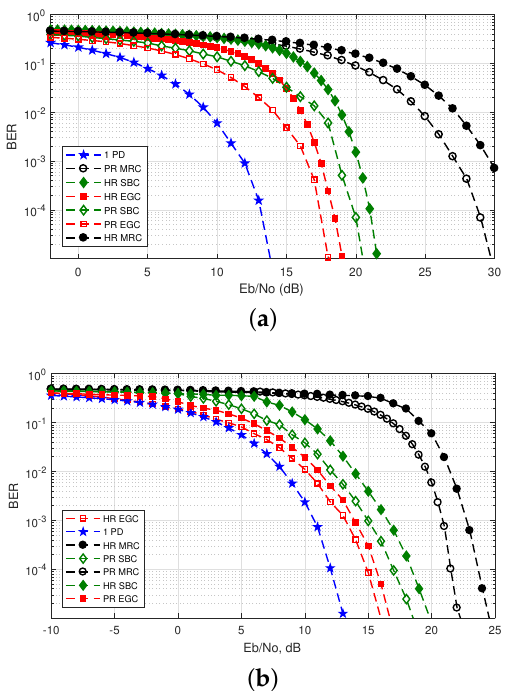
Figure 13. BER as a function of the relationship E b / N 0 for the single PD, hemi-dodecahedron and pyramidal ADRs, with their signal combining schemes in the underground mining VLC scenarios. BER curves for the ( a ) mining roadway and ( b ) mine working face